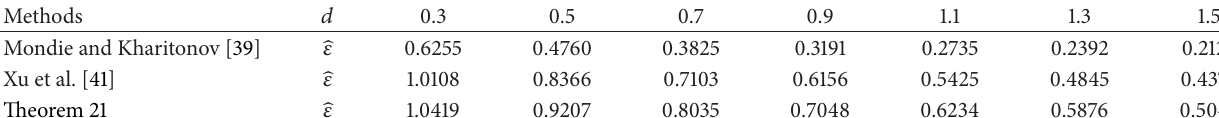
Table 2: Maximum exponential decay rate ̂𝜀 with different parameter 𝑑 .